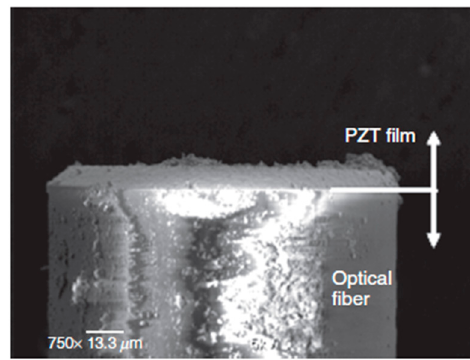
Figure 22. SEM image of PZT-deposited optical fiber edge [50]. © Copyright 2007, IEICE Electron. Express.